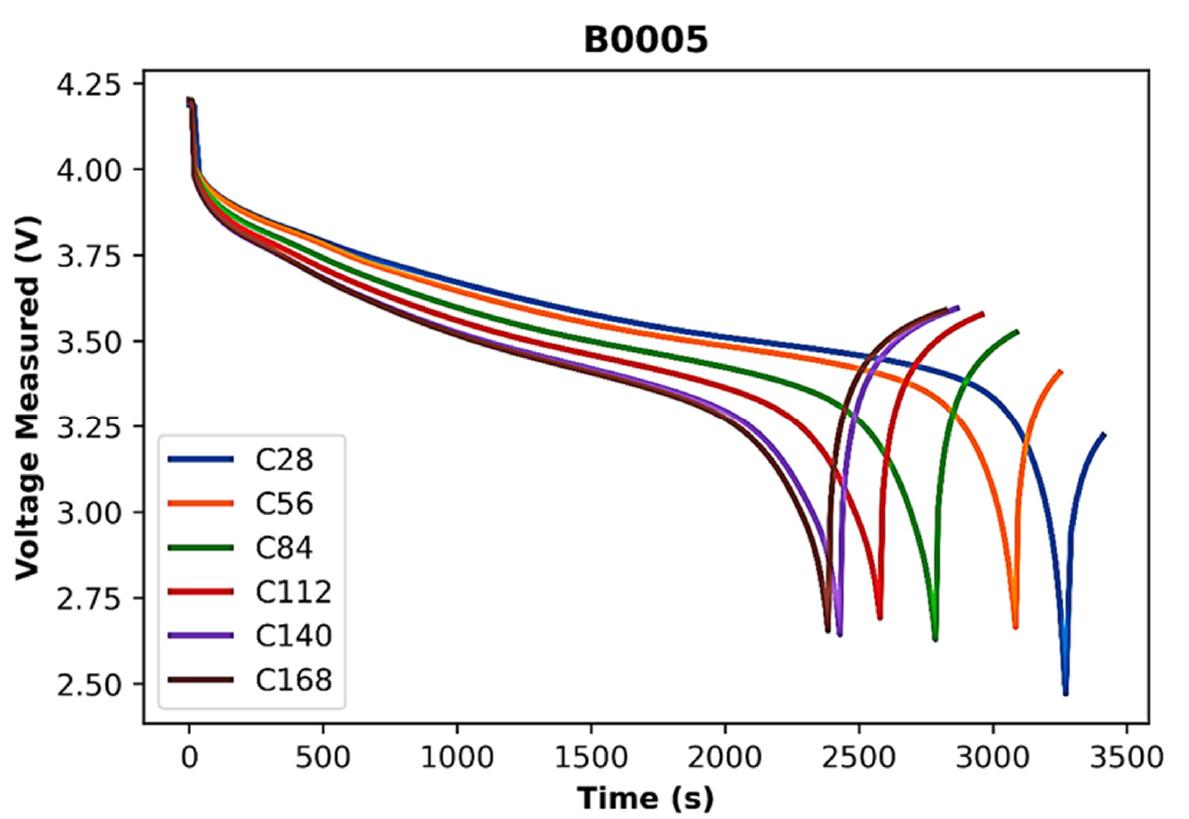
Figure 6. Discharge voltage measured at the battery B0005 at different cycles.